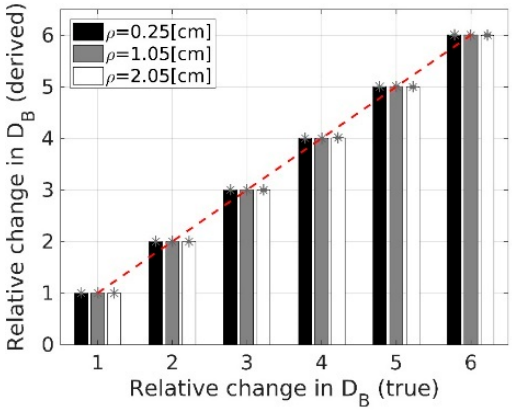
Figure 6. Relative change in extracted flow coe ffi cients (relative to values obtained from media simulated with D B = 5 × 10 − 9 cm 2 / s) at three di ff erent SDS. The true relative change in D B ( x -axis) was obtained from input values to simulations, while the derived values ( y -axis) were obtained from fitted coe ffi cients (see text).